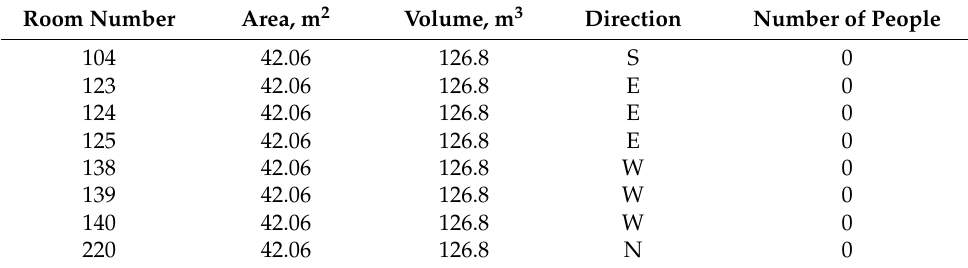
Table 3. Parameters of selected rooms.